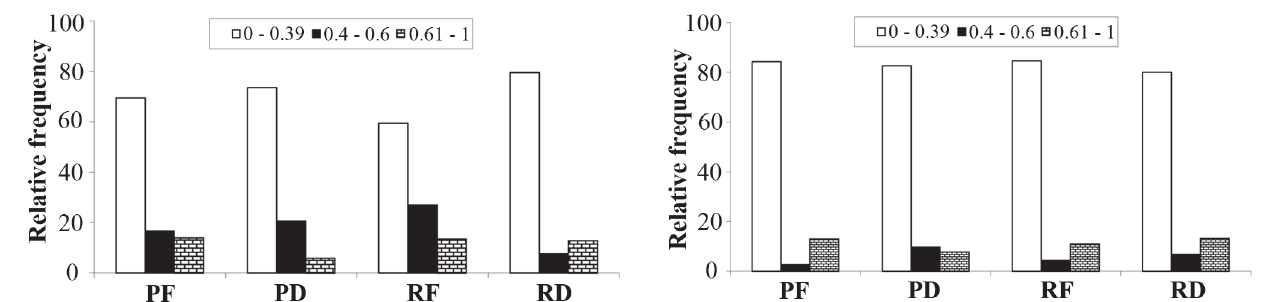
Fig. 3. Relative frequency of the trophic niche breadth ( B intervals of fish species in each spatial-temporal unit in the Cuiabá River basin, Mato Grosso State, Brazil. PF= Pond Flood; PD= Pond Drought; RF= River Flood; RD= River Drought. Trophic niche breadth was considered low (0-0.39), intermediate